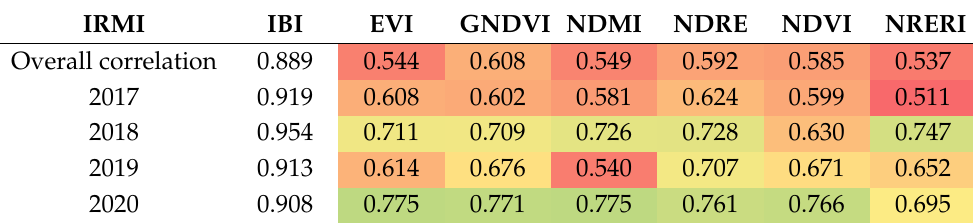
Table 5. Spearman’s rank correlation coefficient for the IRMI vegetation index in the individual years and for the whole period (2017–2020).